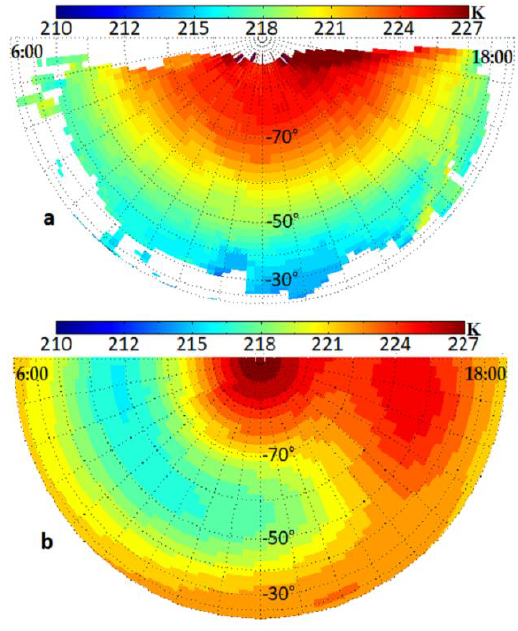
Figure 5. Nighttime polar temperature field (K) at 2 × 10 3 Pa (roughly corresponding to 72 km) for ( a ) VIRTIS-M and ( b ) the IPSL Venus GCM simulation.